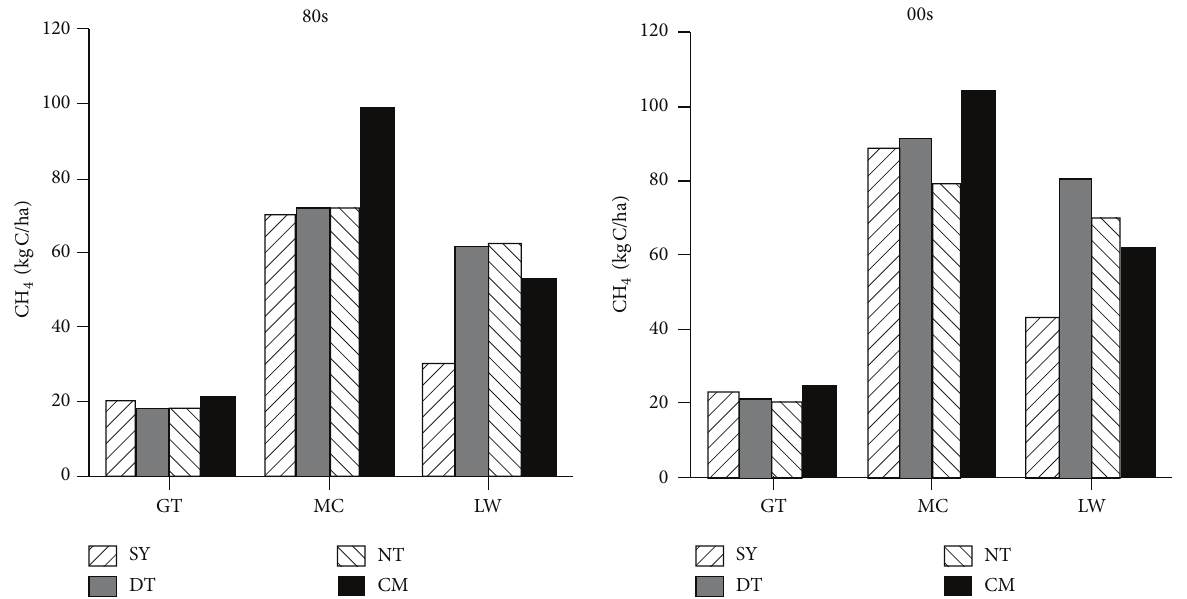
Figure 2: Comparison of CH 4 emission flux of different beach in 80s and 00s (SY, DT, NT, and CM represent Sheyang, Dongtai, Nantong, and Chongming, resp.; GT, MC, and LW represent bare beach, Spartina beach, and Phragmites beach, resp.).